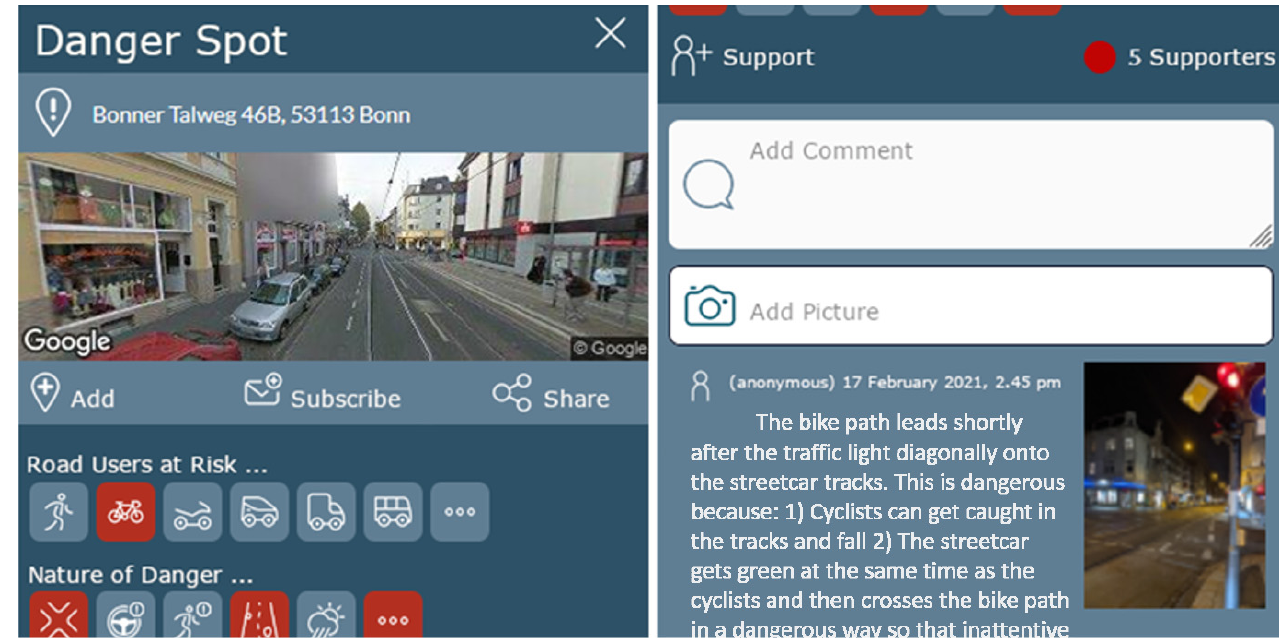
Figure 2. Example danger spot from the city of Bonn (cut and divided into two columns). At the moment, the platform operates in German only; we inserted the English translation in this figure for demonstration in the present paper.